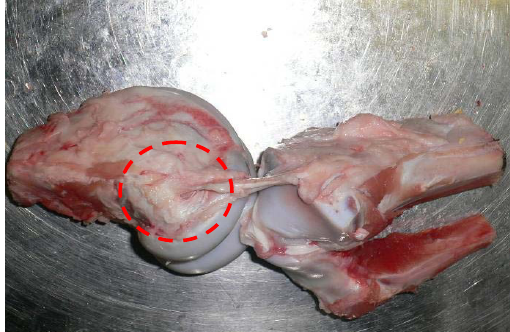
Fig. 6 Injury pattern of knee joint for drop height of 300 mm (test 5). The upper insertion of MCL is